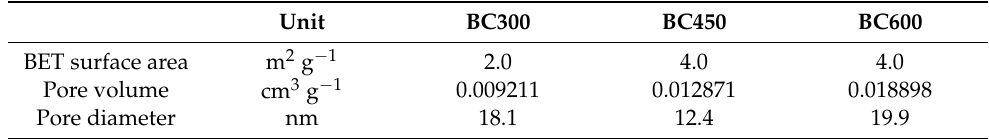
Table 2. Structural characterization of biochar samples from Macrocystis pyrifera produced at different pyrolysis temperatures (300, 450, and 600 ◦